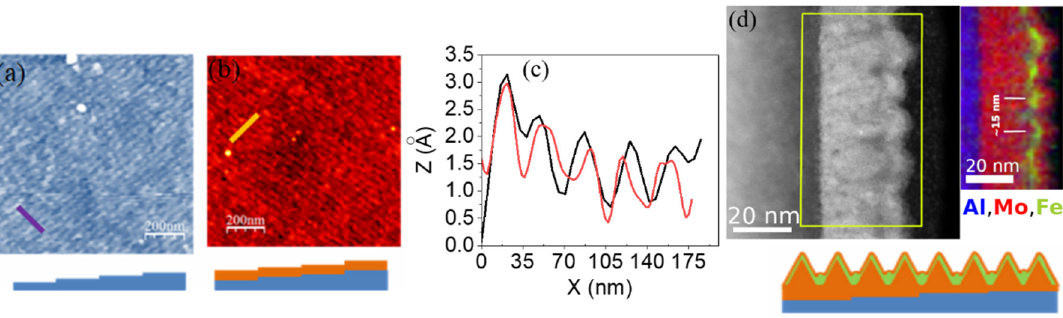
Figure 1. Microscopic images of the linear systems with the corresponding schematic representation in the lower part of the figure. ( a ) AFM image of the planar surface of Al 2 O 3 substrate with atomic terraces of 35 nm average periodicity. ( b ) AFM image of the wetting layer of Mo surface following the structure of the Al 2 O 3 substrate that was used for the deposition of the template presenting Mo linear trenches. ( c ) Topographic profiles realized over the lines marked in ( a , b ). ( d ) TEM image and the elemental spectroscopic analysis (inset) in a profile plane of a Fe sample prepared by deposition on Mo trenches. The sample is covered with a thin Mo layer against oxidation processes.